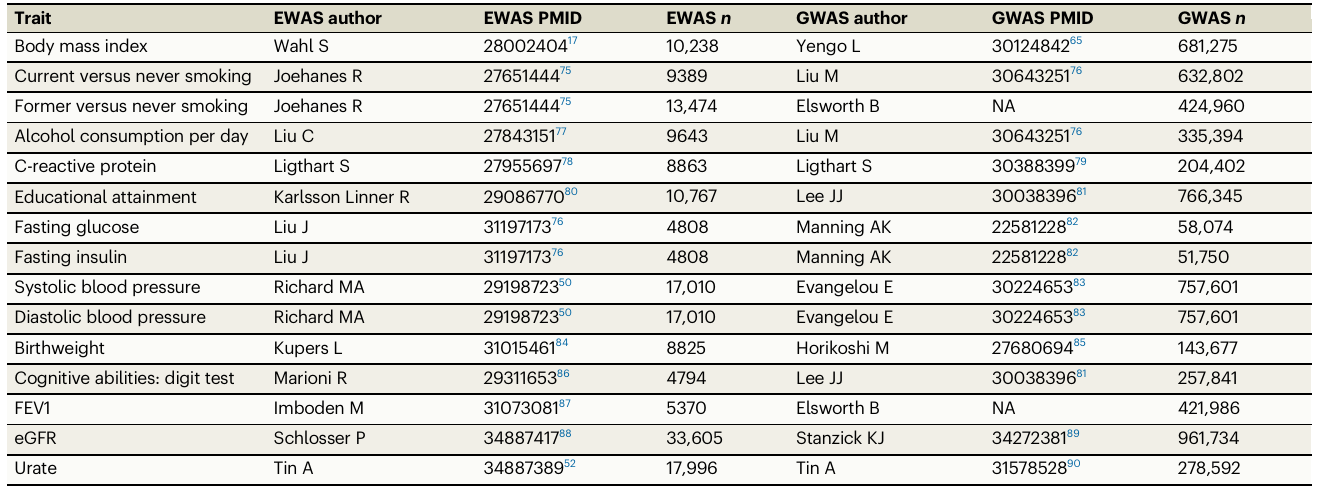
Table 1 | Study data Trait